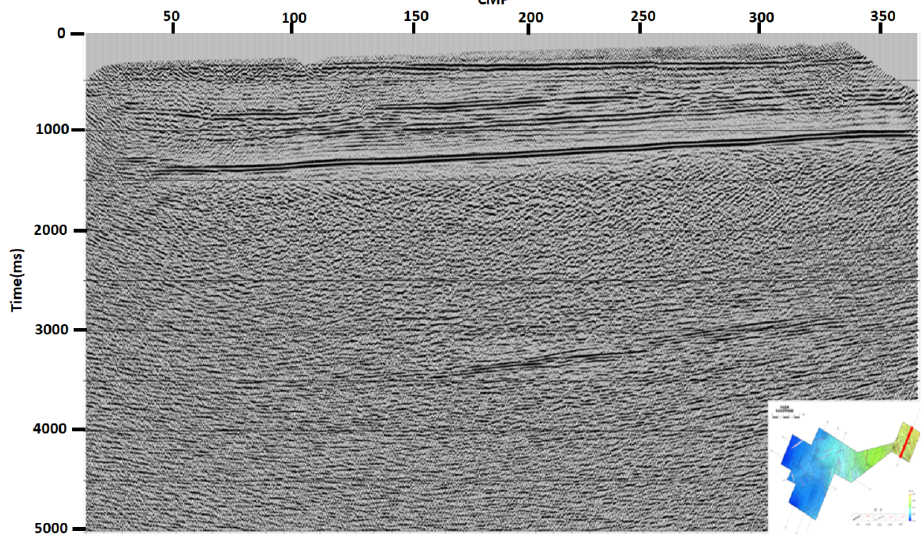
Figure 12. The new section of the data acquired from the HDR in Gonghe